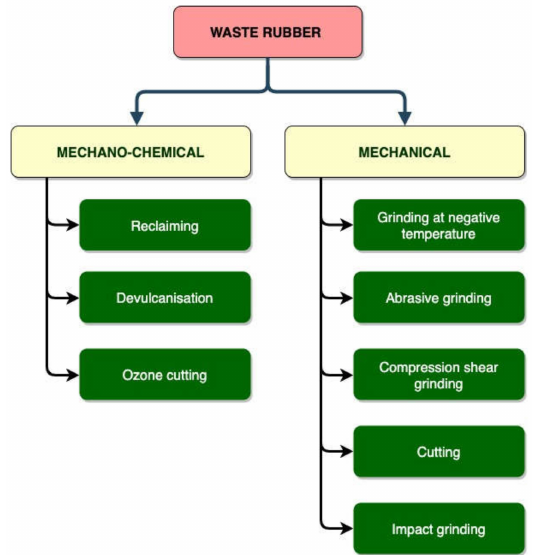
Figure 3. Waste rubber processing methods (author’s